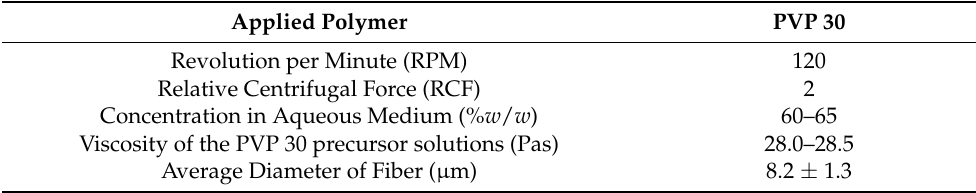
Table 1. Formulation parameters and average diameter of contact-spun